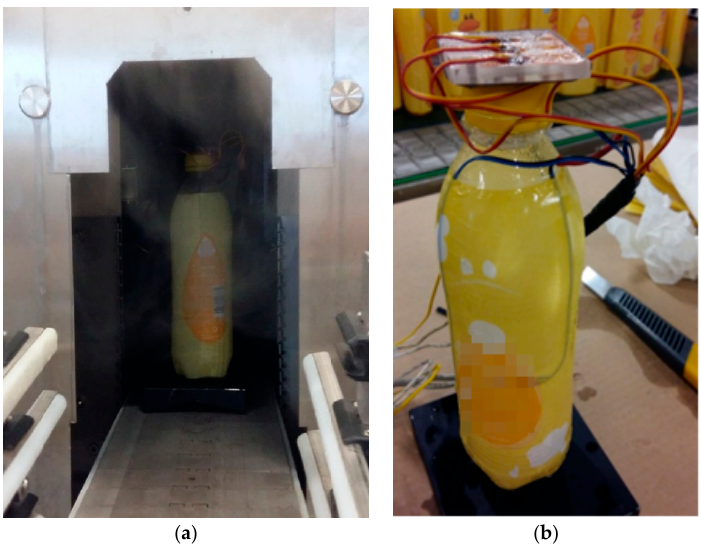
Figure 9. The stand with the bottle and shrunk film: ( a ) at the steam tunnel outlet; ( b ) after cooling.